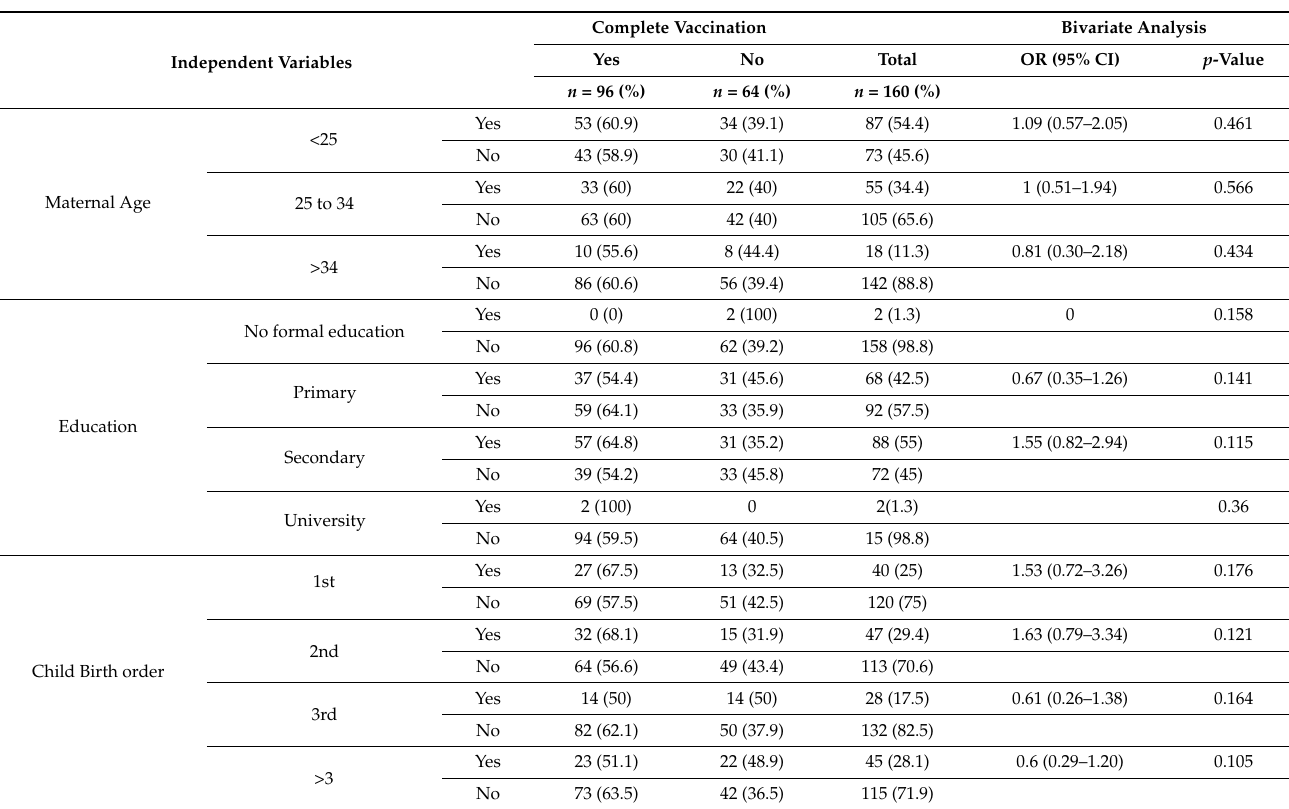
Table 3. Sociodemographic characteristics of participants ( n = 160) and their associations with complete childhood